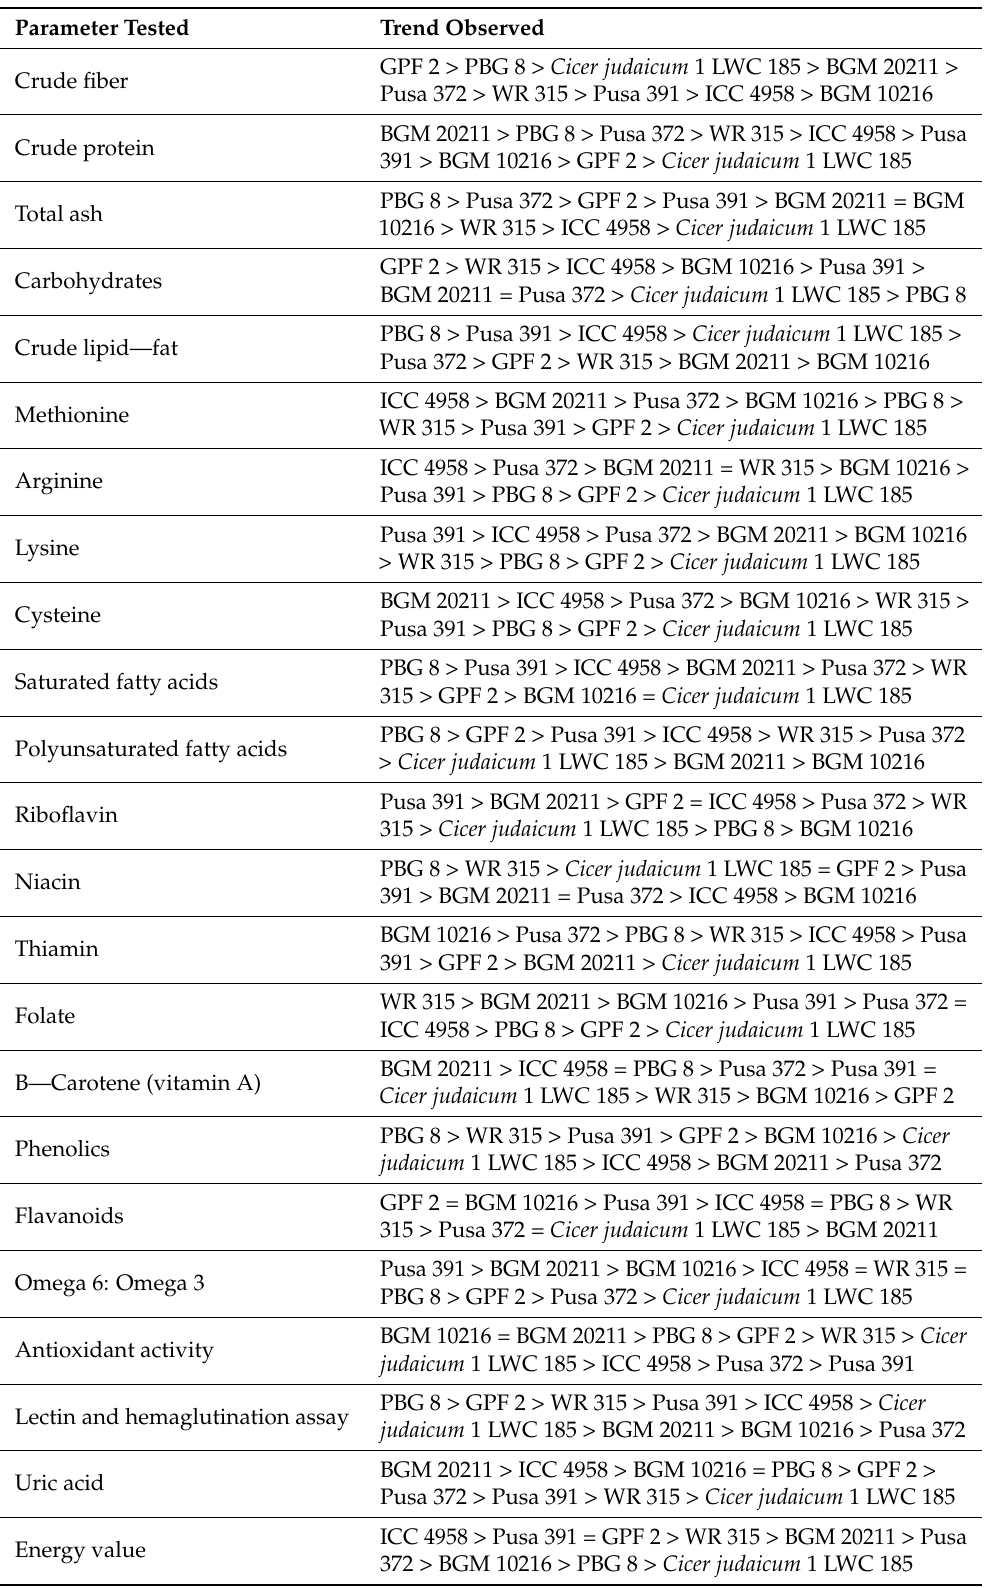
Table 6. Biochemical analysis of selected chickpea